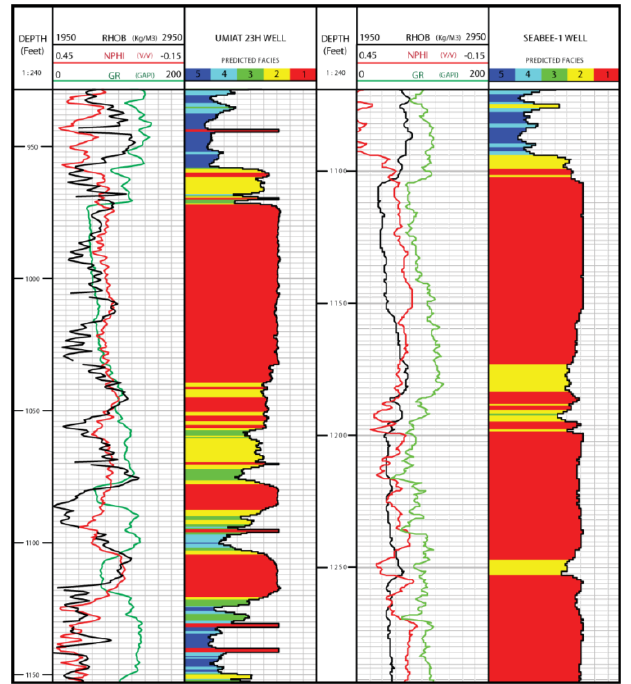
Figure 6. Umiat test wells (Umiat 23H and SeaBee-1), showing predicted lithofacies from the available well data using the SOM algorithm with 7 × 7 neurons.